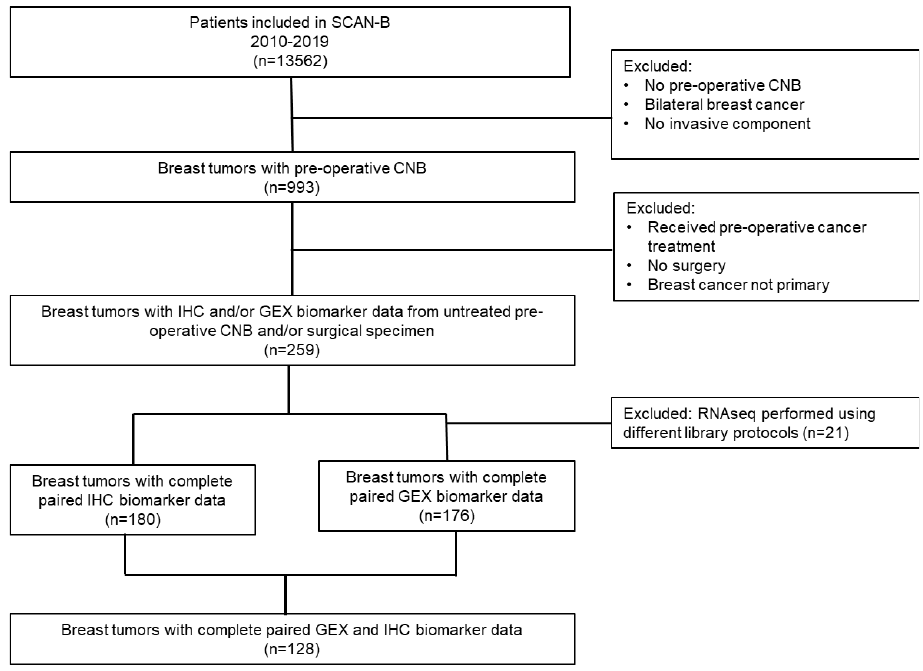
Figure 1. Flowchart showing the selection of the study specific cohort ( n = 259) from the SCAN-B cohort.